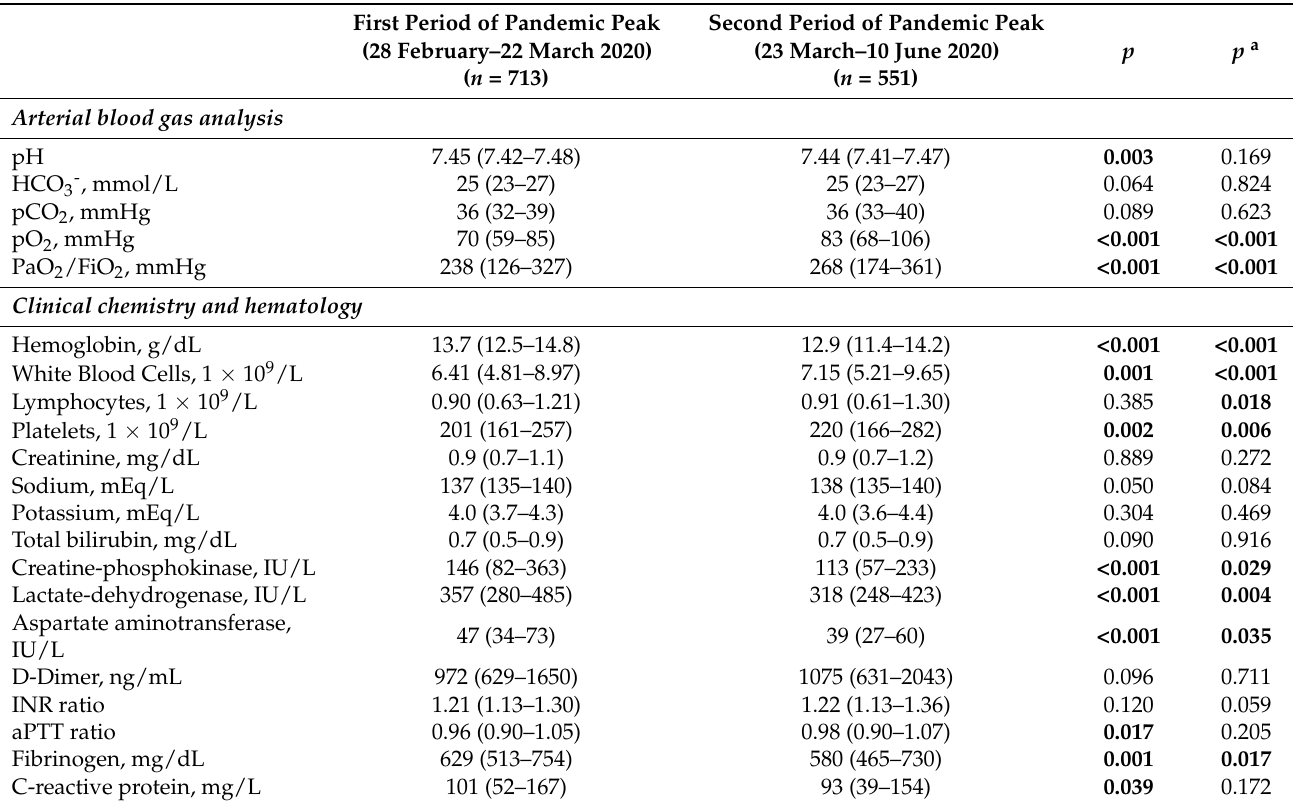
Table 2. Comparison of the main laboratory findings on hospital admission of patients during different periods of the pandemic